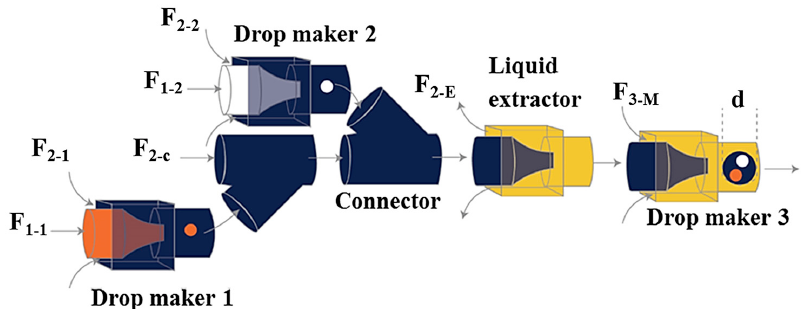
Figure 20. Generation of quadruple-component double emulsions using an assembly consisted of 3 drop makers, 2 connectors, and one liquid extractor. A PVC tube is used to connect the round capillaries of two adjacent drop makers. F i-j is the inlet/outlet stream at each level, where the subscripts i and j refer to the level number and the injection position respectively. The drop maker 1 generates the inner drops of F 1-1 , the drop maker 2 generates the inner drops of F 1-2 , and the drop maker 3 generates the outer drops of F 3-M [61].